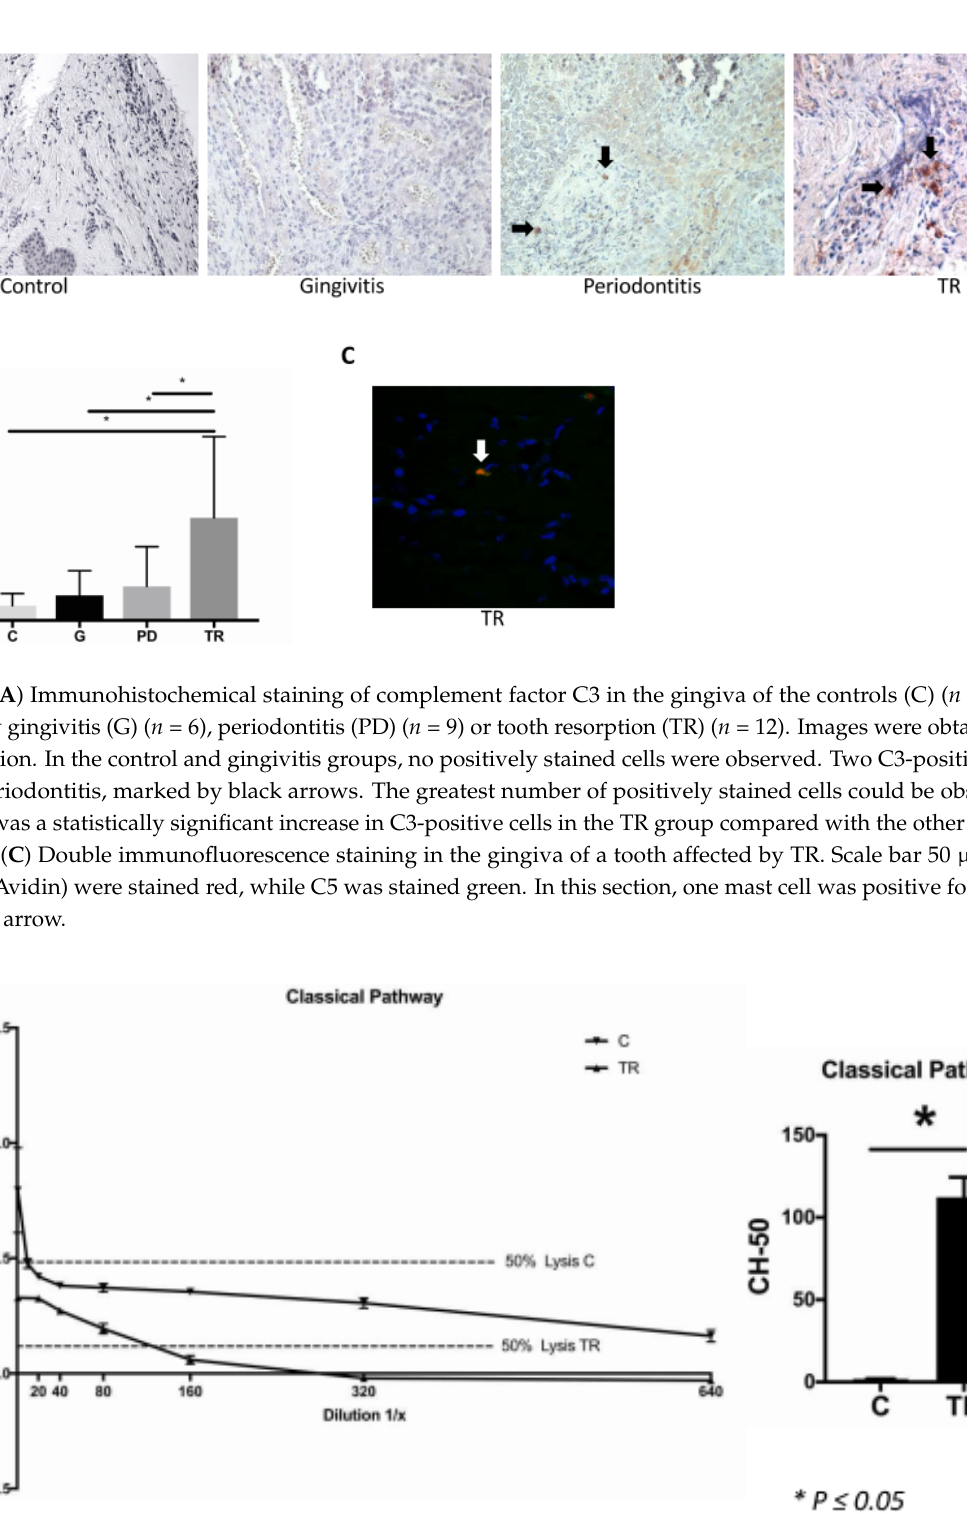
Figure 7. Hemolytic assay for the detection of complement classical pathway function. The optical density of the serum samples of both the control (C) and tooth resorption (TR) groups were plotted against the dilution factor. The curves show the control (4 cats) and TR groups (12 cats) with different levels of complement function. In TR, 50% lysis occurred between serum dilutions 1:80 and 1:160, in the control group between the undiluted serum and dilution 1:10. There was a significant difference in the serum complement concentration between the two groups, being significantly higher in the TR group than in the control group ( p ≤